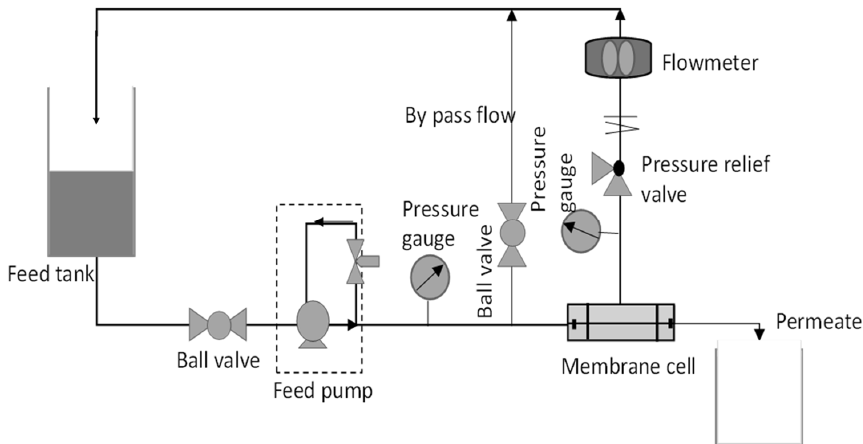
Figure 1. A complete set up of cross flow filtration membrane system.